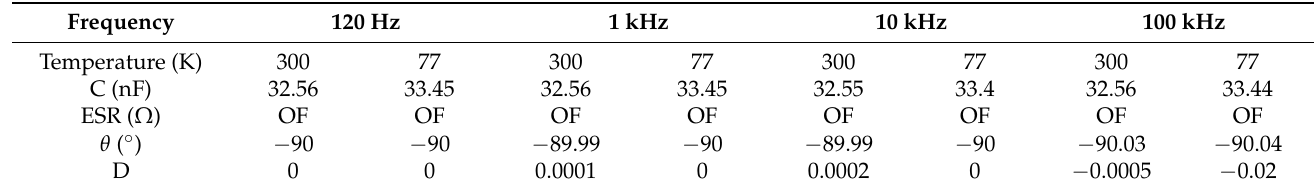
Table 4. The electrolytic capacitor test results at different temperatures and frequencies.